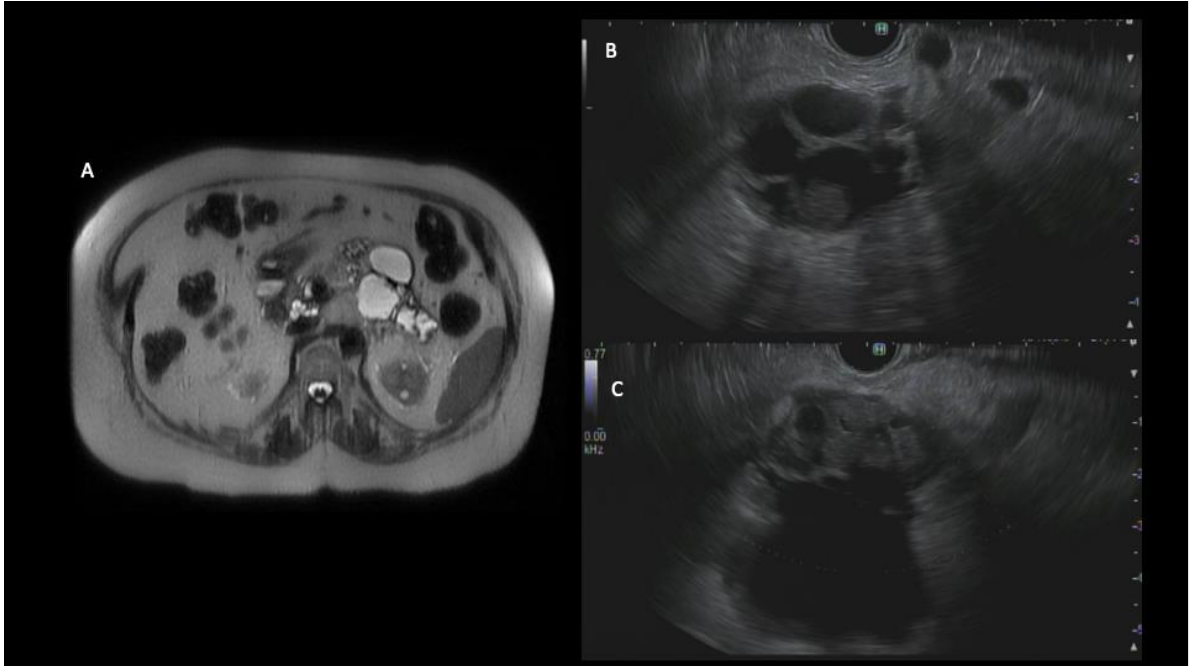
Figure 2. MRI of a 79-year-old female showed numerous cystic lesions with rapidly enlarging cysts in the distal body and tail of the pancreas ( A ). An endoscopic ultrasound demonstrated an approximately 50 mm cyst in the body of the pancreas associated with mural nodularity and pancreatic ductal dilation up to 20 mm ( B , C ). A fine-needle biopsy was obtained and showed evidence of at least high-grade dysplasia. The patient underwent distal pancreatectomy and was diagnosed with invasive moderately differentiated adenocarcinoma (T3N0M0).